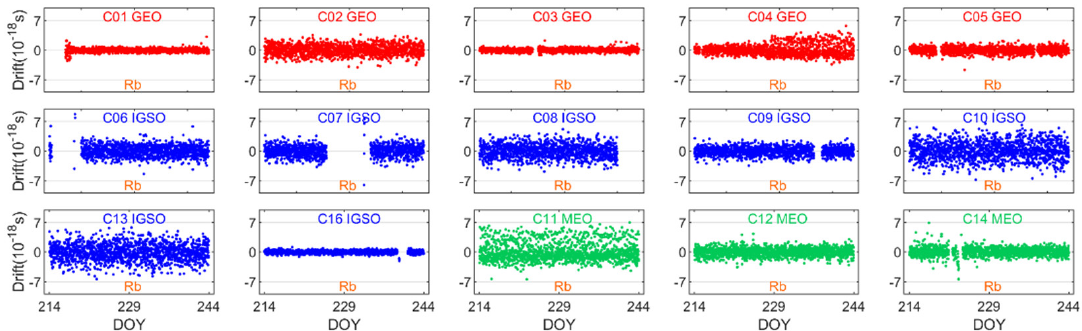
Figure 9. Frequency drift series of BDS-2 satellites.